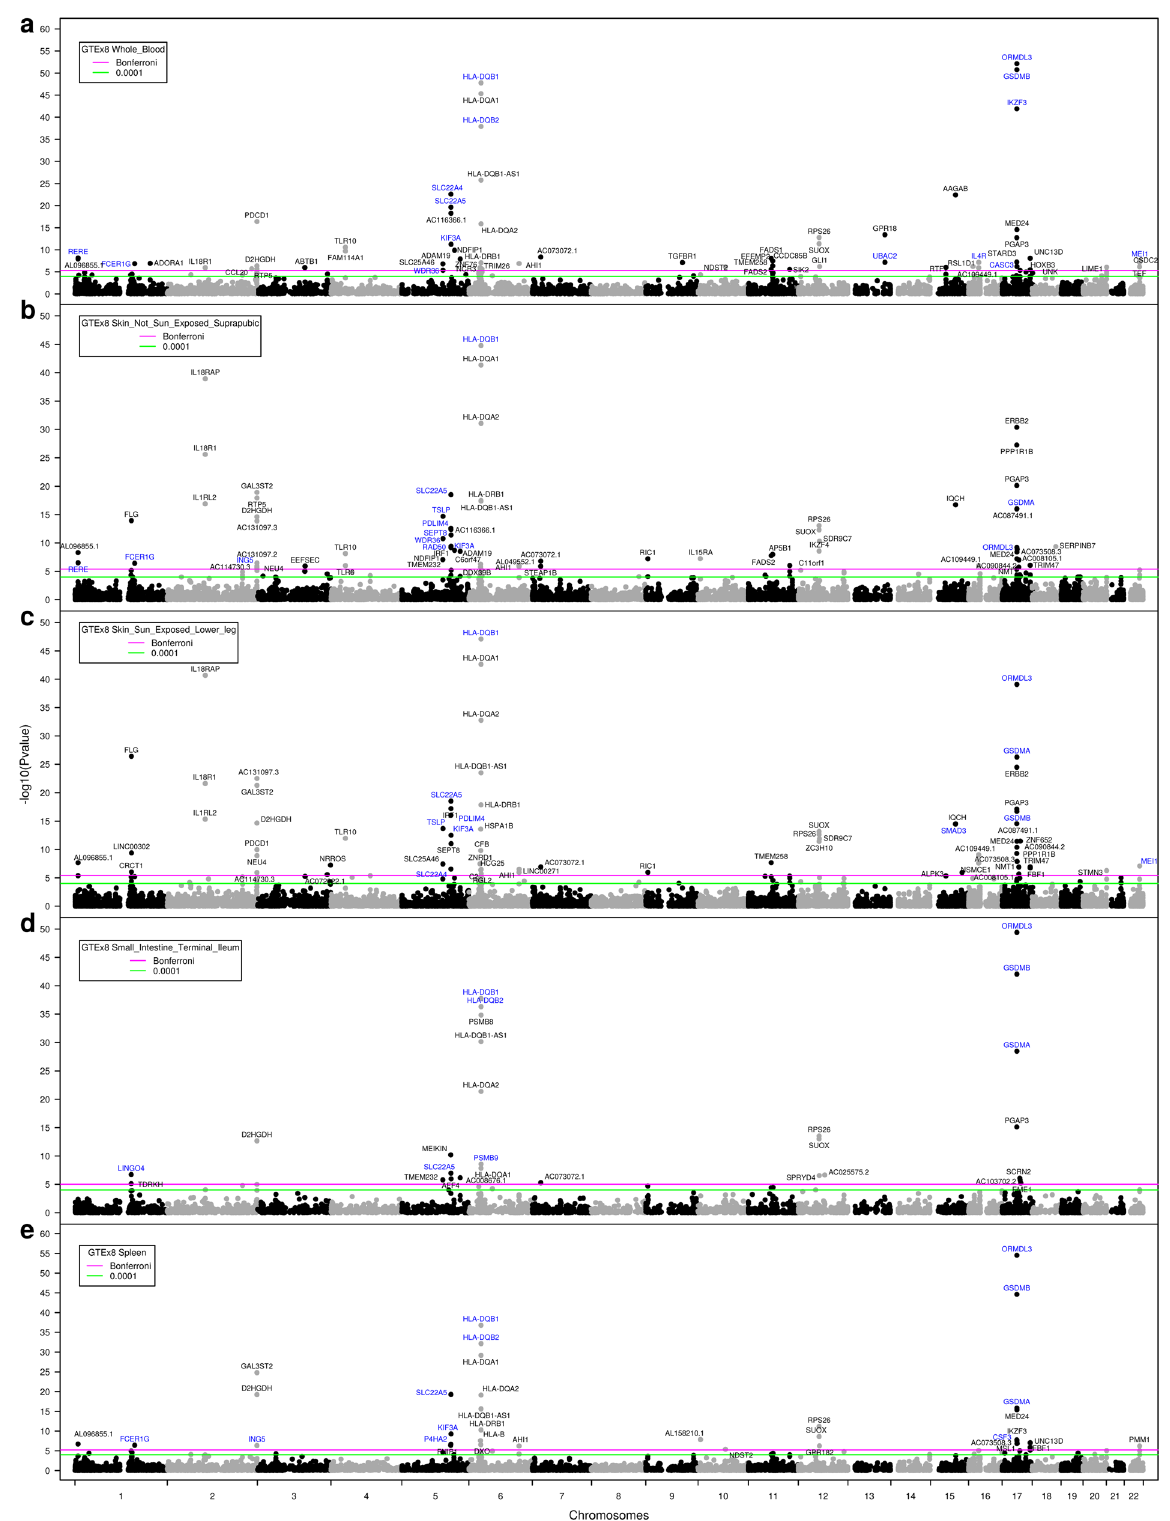
Fig. 4 Manhattan plots of the TWAS on asthma integrating the UK Biobank GWAS and the eQTL from fi ve tissues in GTEx. TWAS results for a in blood, b in skin not sun exposed, c in skin sun exposed, d in small intestine and e in spleen are illustrated. Each dot represents the association between predicted gene expression and asthma for a speci fi c gene/transcript. P values for gene expression-asthma associations are on the y axis in − log10 scale. The green and magenta horizontal lines represent P TWAS of 0.0001 and Bonferroni, respectively. Annotations for genome-wide signi fi cant genes/ transcripts that passed Bonferroni correction are indicated. Genes in blue have also been identi fi ed in lung tissue.